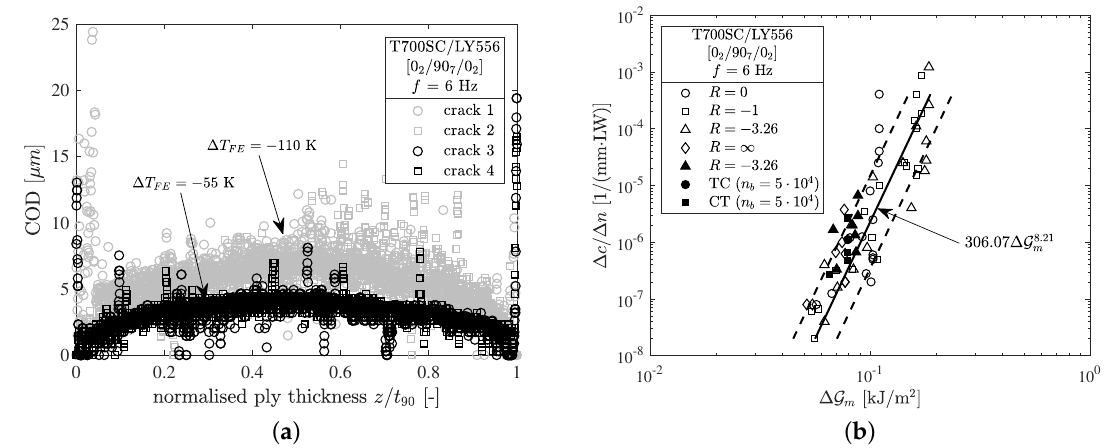
Figure 4. Comparison of the ( a ) residual CODs of the specimens tested previously (light symbols) [5,6] and specimens tested at present (dark symbols) as well as ( b ) crack density growth rate ∆ c / ∆ n vs. the range of the strain energy release rate ∆ G m for the initiation of a